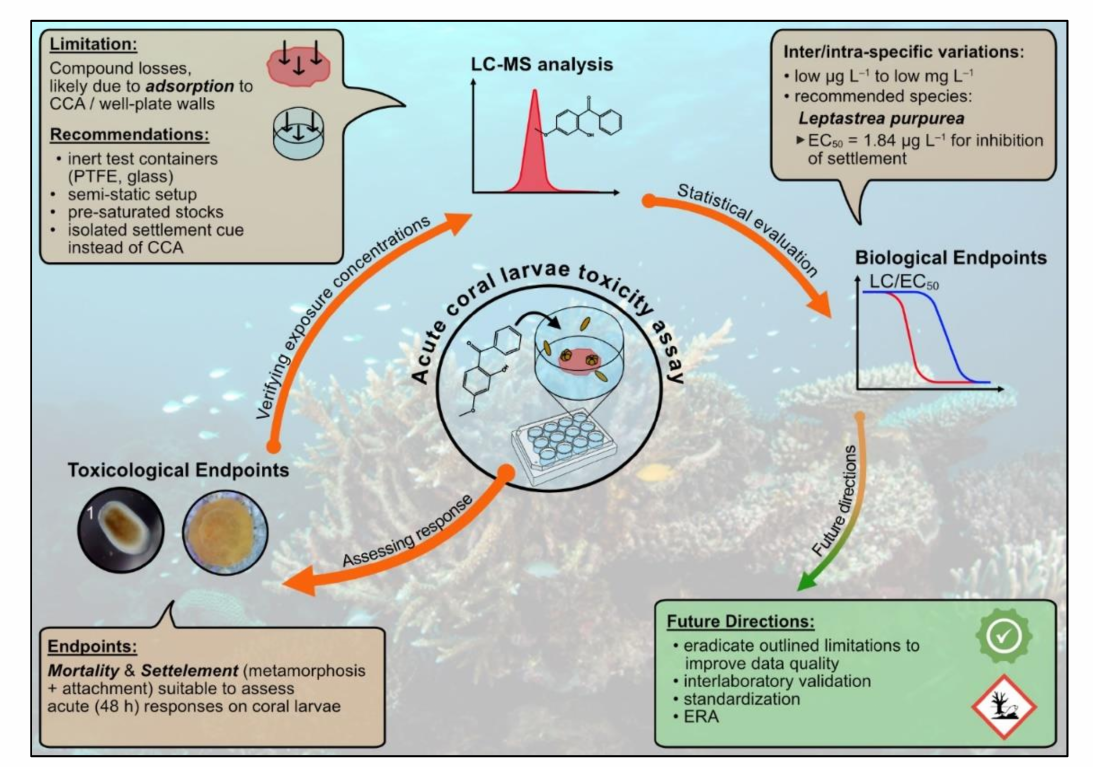
Figure 5. Schematic summary of the here performed experiments and data analyses. 1 Photo courtesy of L.